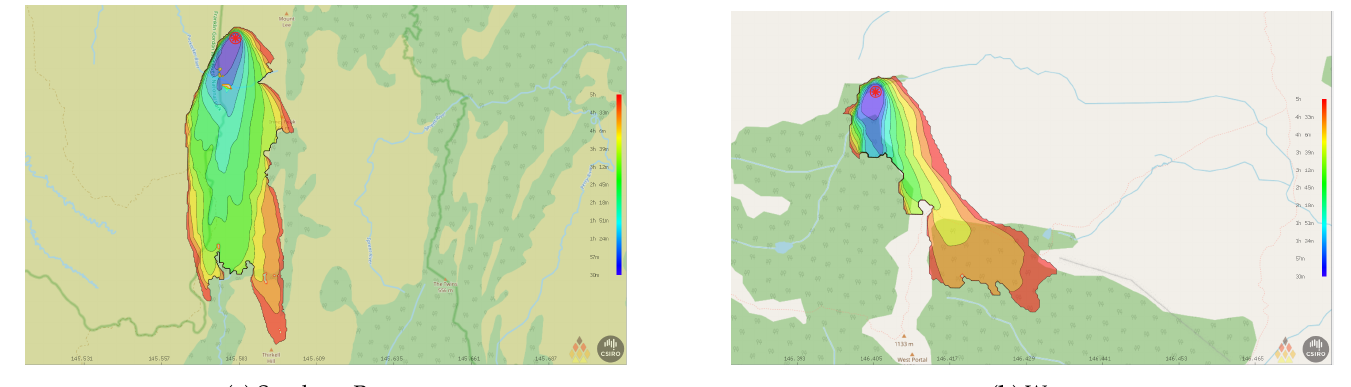
Figure 3. Illustration of simulation in Fire dynamics in Spark ( T = 40, R = 90, W = 60). The wildfire propagates differently based on the fuel load and land topography and consequently, the total area burnt by the fire varies based on the bio-region. Different colors represent the area burnt by the fire over time in half hourly steps. The purple color represents the area burnt by the fire in the first half hour, while the red color represents the area burnt from 4.5–5 h